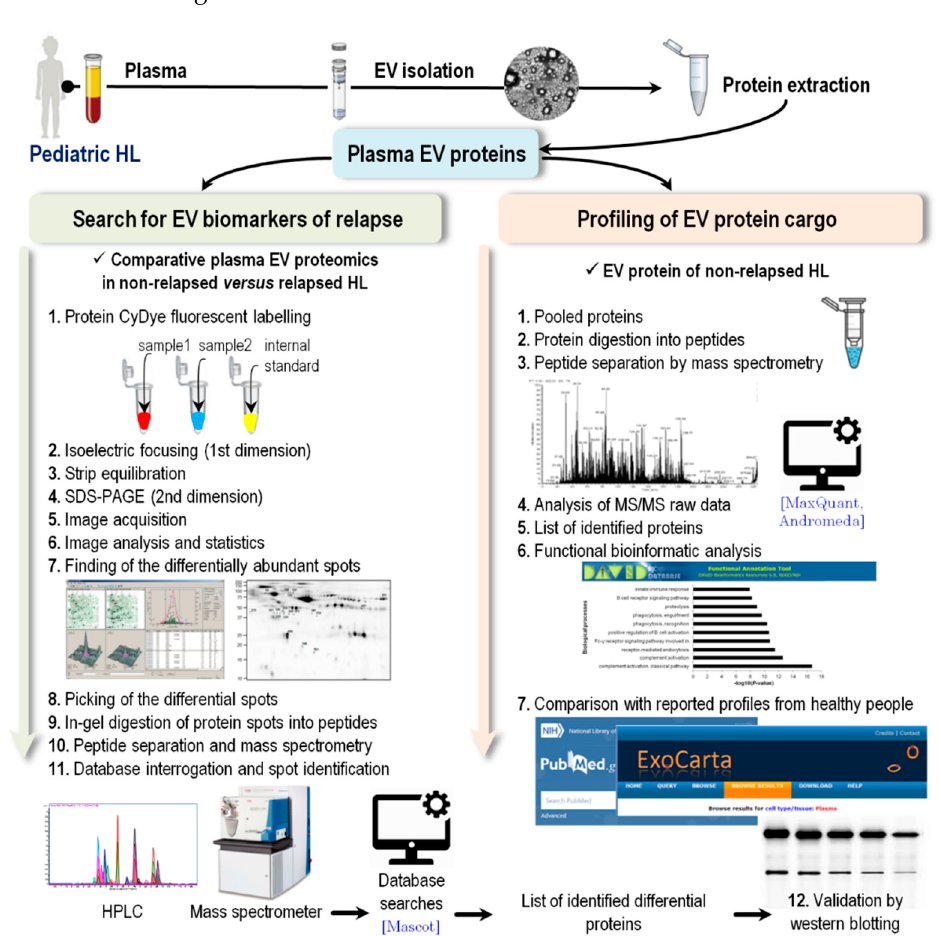
Figure 2. Schematic illustration of the experimental workflow adopted from plasma sampling to LC–MS/MS and computational analyses.